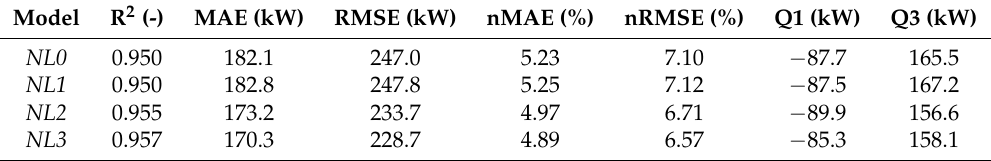
Table 3. Error analysis on the load forecast, from +24 to +48 h, for different forecast approaches. Row NL0 shows the results without taking into account weather influence and using as predictor only statistics about load two and seven days before. Row NL1 refers to the forecast obtained adding as predictor forecast of temperature at 2 m from the ground; NL2 as before but using as predictor, forecast for GHI instead of T2 . The last row shows the results for model NL3 , in which a separate model forecasts the photovoltaic distributed generation. The values of nMAE and nRMSE are normalized mean absolute error and root mean squared error with respect to the mean value of the measured